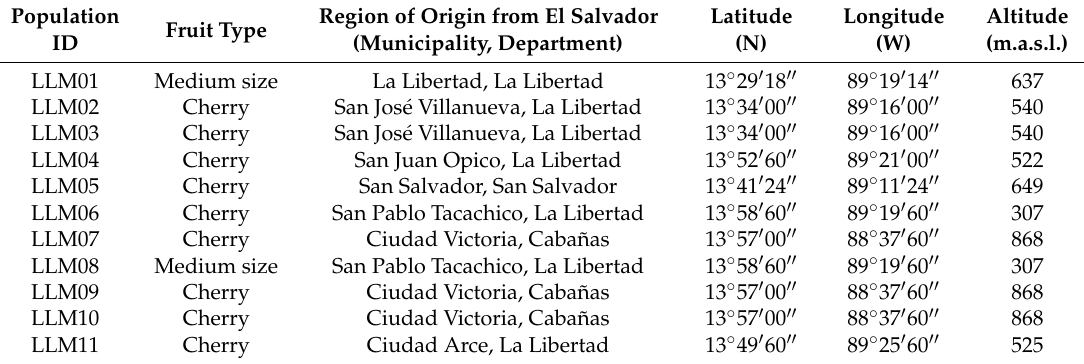
Table 1. Regions of origin for the characterized accessions of tomato from El Salvador, Central